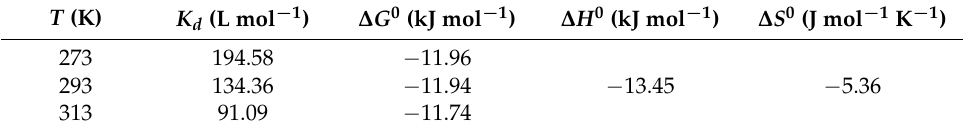
Table 2. Thermodynamic parameters of the removal of methylene blue by bone char.